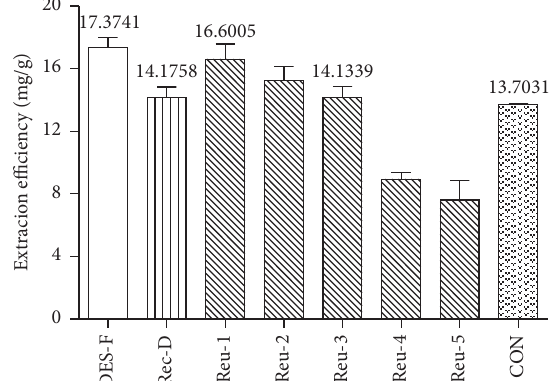
Figure 6: Evaluation recovery of extracted flavone di-C-glycosides from DES-F and DES reusability. Rec-D, recovery-D101; Reu, reusability; CON, 40%